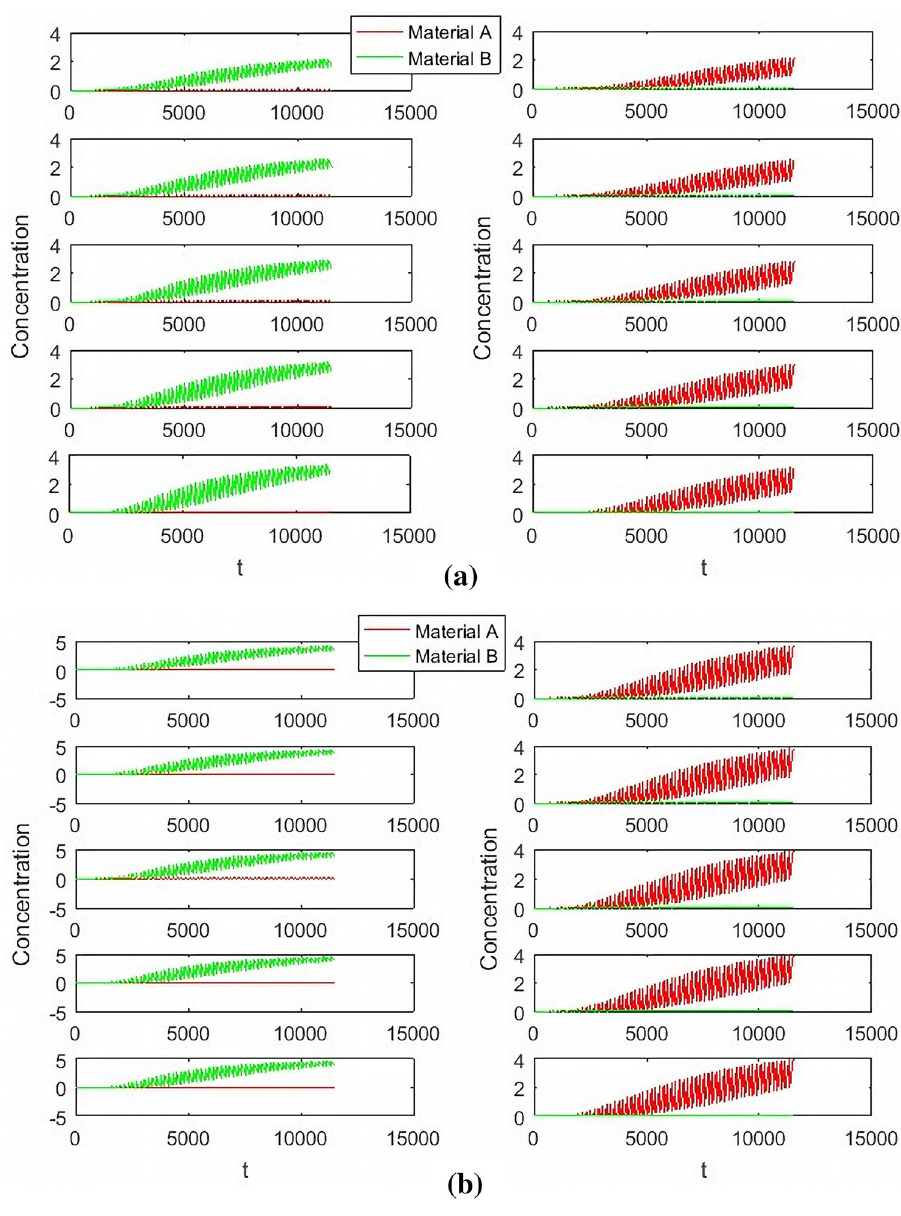
Figure 6. The influence of Zone 3 Flow rate for